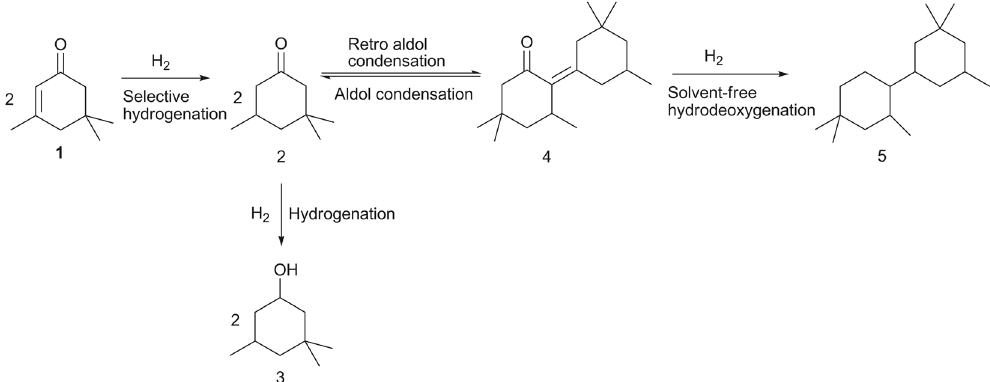
Figure 1. Strategy for the synthesis of compound 2 with isophorone and hydrogen.